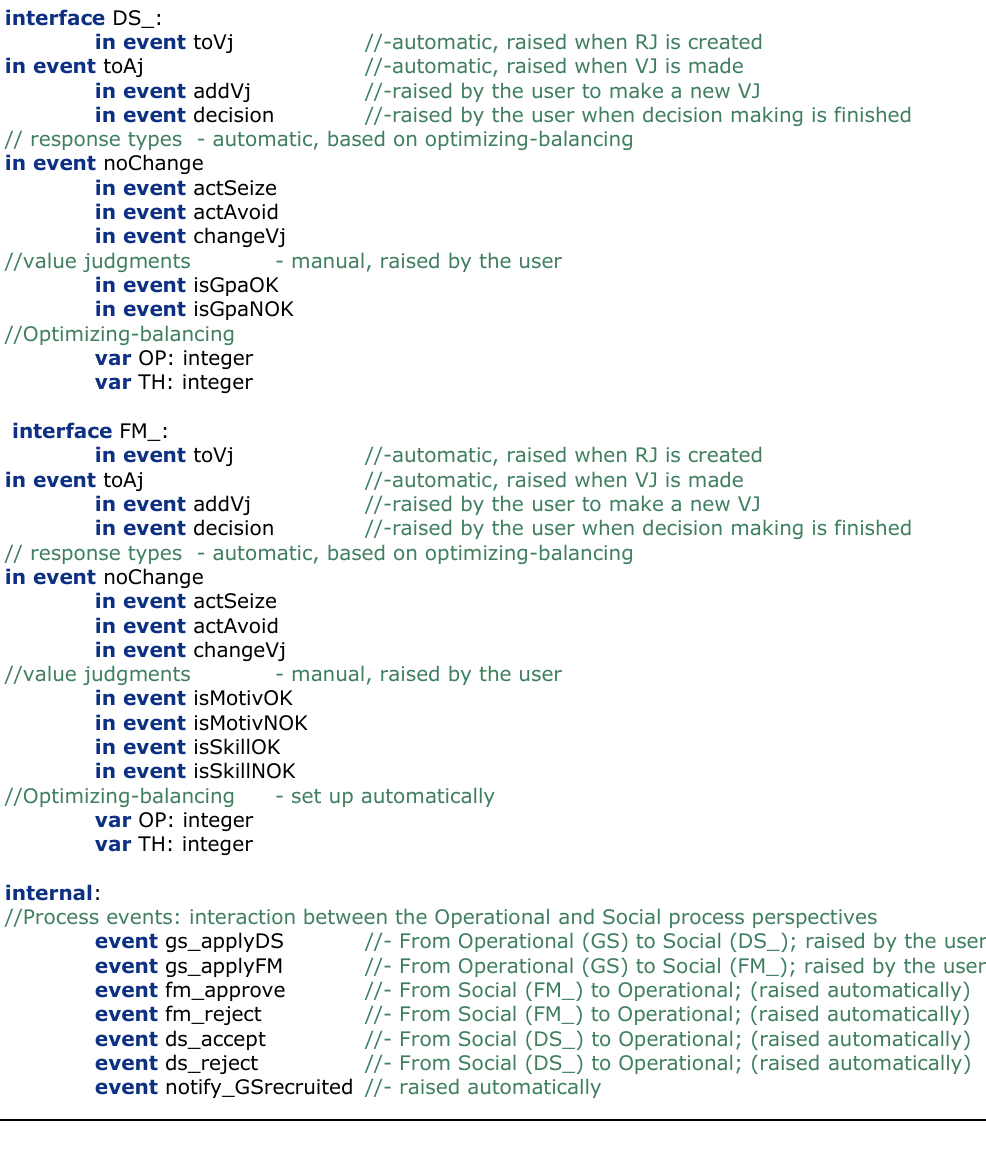
Figure 14. The list of events from the extended process model. These events represent the actual judgments made in the mind of the actor. During the simulation, the corresponding events have to be triggered